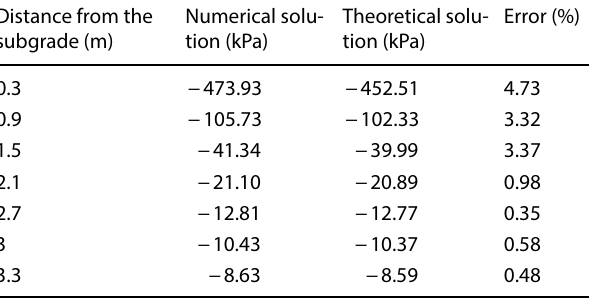
Table 6 Correlation between numerical and theoretical solutions Distance from the subgrade